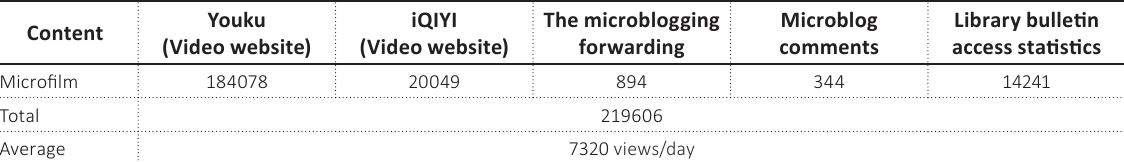
Table 2. Statistics of visitors of “love library” microfilm